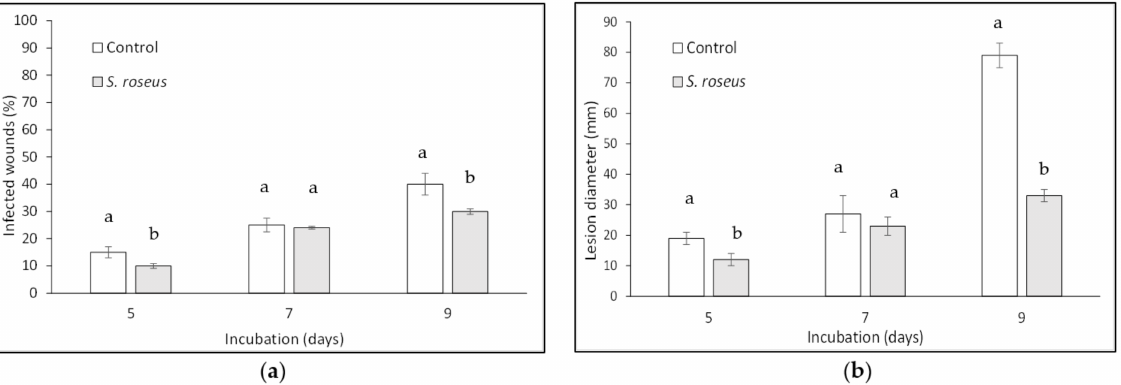
Figure 4. Sporobolomyces roseus effect on blue mold incidence ( a ) and severity ( b ) on apricot cv. Kioto. Fruit were wounded, yeast-treated, pathogen-inoculated, and stored at 20 ± 1 ◦ C for 9 days in the dark and high relative humidity. Data are the mean of three replicates ± standard error of the mean (SEM). Bars with different letters are statistically significant ( p ≤ 0.05) according to Duncan’s Multiple Range Test